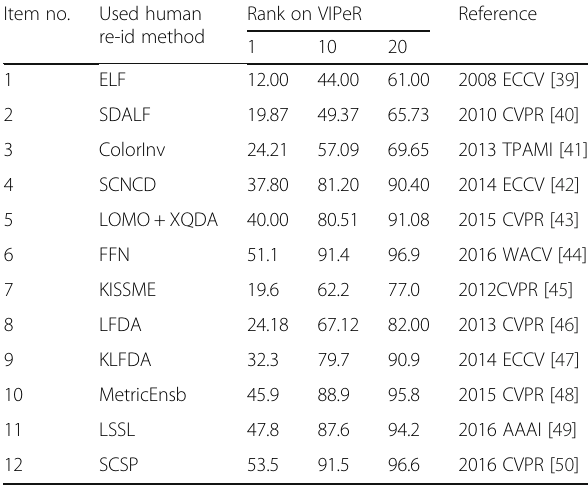
Table 5 Quantitative comparison of human re-id across cameras on a quite challenging VIPeR benchmark dataset Item